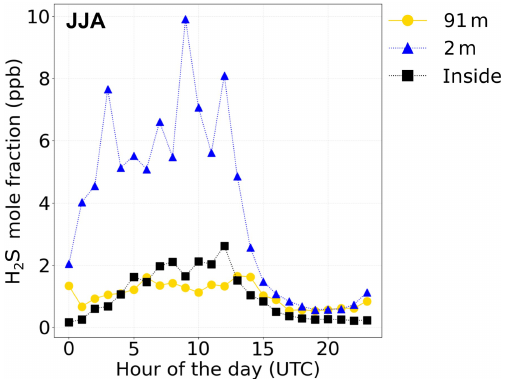
Figure 6. Diurnal cycle of H 2 S measured at the Hobbs site during the summer months (June, July,